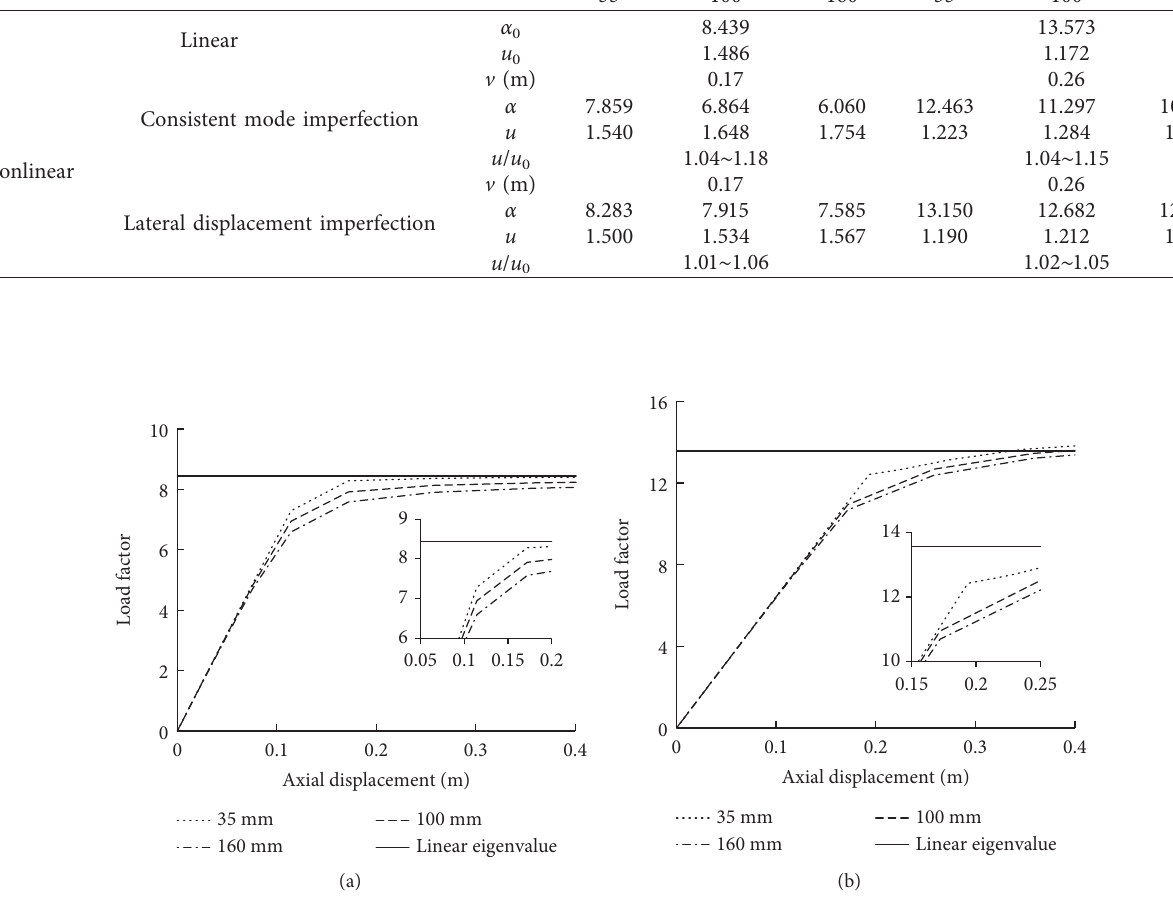
Figure 14: Load factor of the lateral displacement imperfection. (a) Case 1. (b) Case 2.